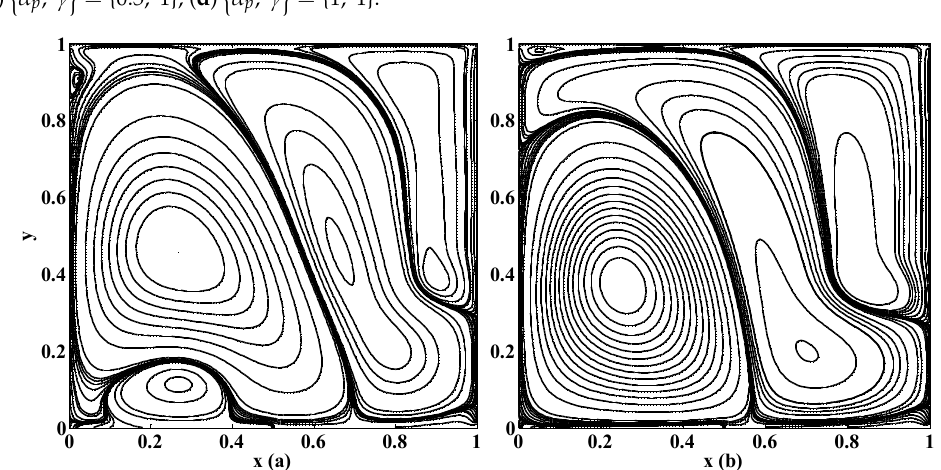
Figure 5. Streamlines for { S t , R } = { 0.005, 400 } if ( a ) (cid:110) (cid:111) α γ = { 0.5, 1 } ; ( d ) ( c ) p ,